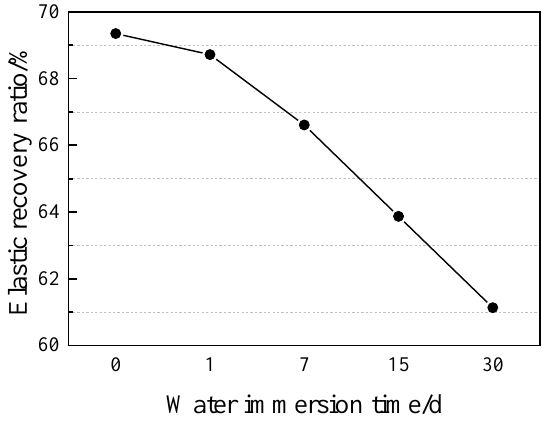
Figure 6. Elastic recovery ratio of PCFC under different water immersion time.